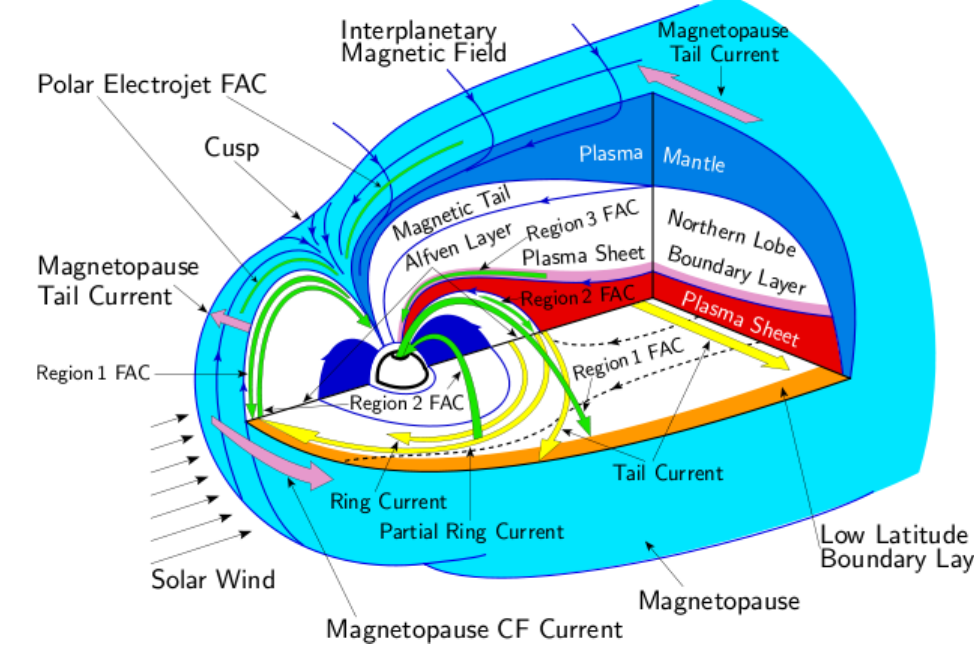
Figure 11. The 3-D system of electric currents in the magnetosphere during magnetic disturbances (Feldstein et al., 2006). Descriptions of the current system and the magnetospheric plasma structures are given in the